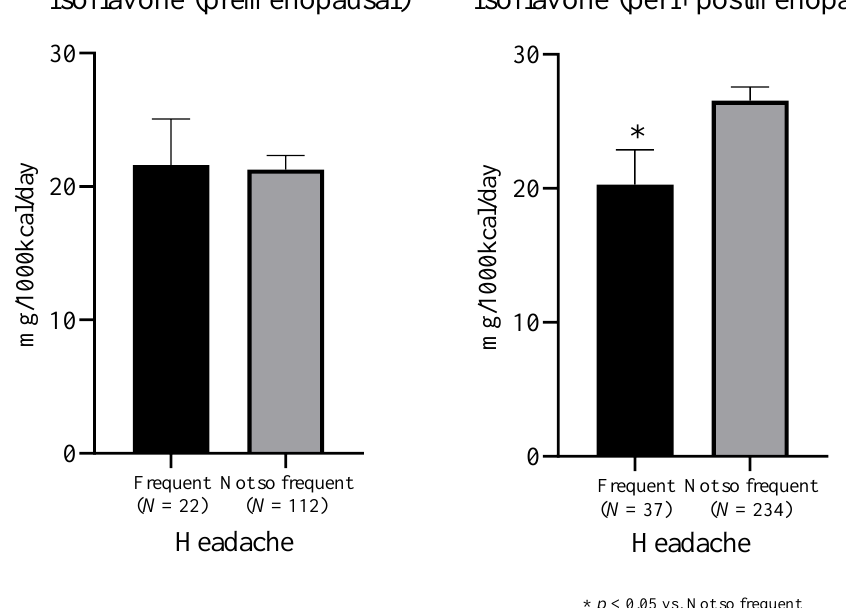
Figure 1. Comparison of daily isoflavone intake by menopausal status between women with frequent headaches and those without. * p < 0.05 vs. Not so frequent, Mann-Whitney test.